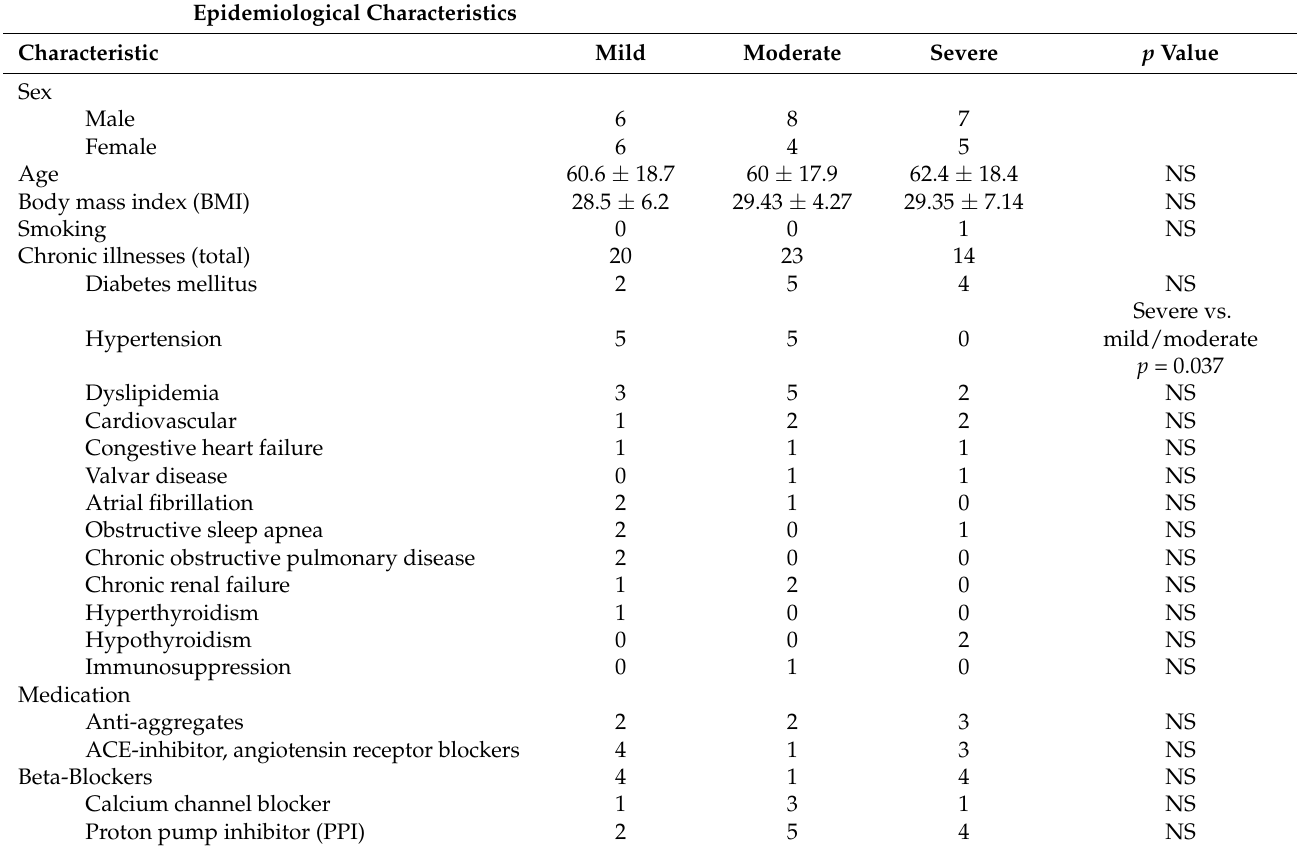
Table 1. Clinical characteristics of the study